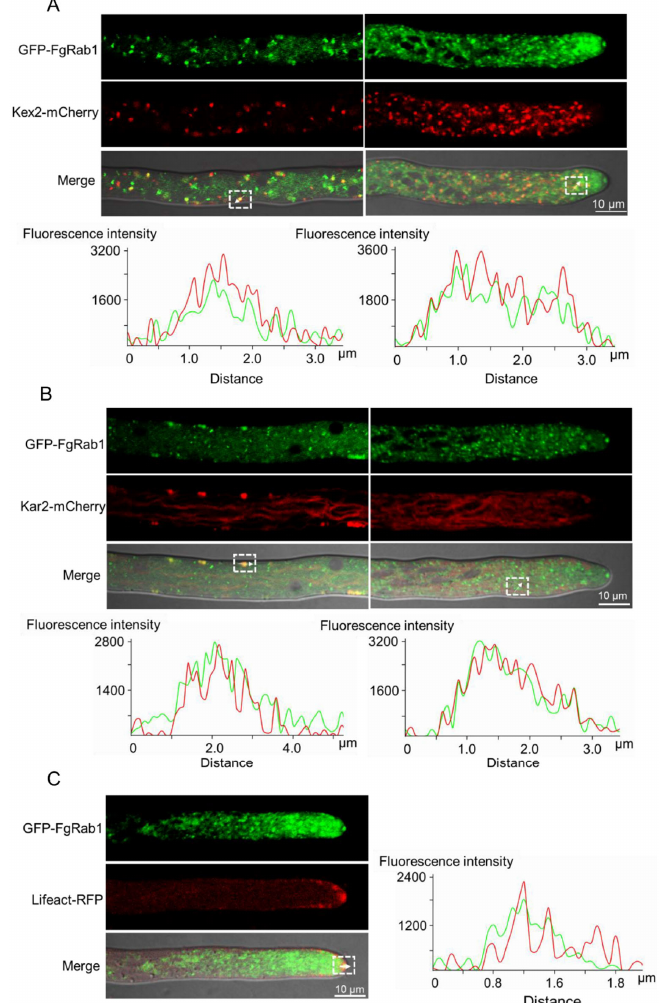
Figure 4. Subcellular localization of FgRab1. ( A ) GFP ‐ FgRab1 co ‐ localizes with the trans ‐ Golgi marker Kex2 ‐ mCherry (marked by white arrows). A line scan graph was generated at the indicated position (arrow) to show the relative localization of GFP ‐ FgRab1 (green) and Kex2 ‐ mCherry (red). ( B ) GFP ‐ FgRab1 and Kar2 ‐ mCherry co ‐ localize to the endoplasmic reticulum (ER) (marked by white arrows). A line scan graph was generated at the indicated position (arrow) to show the relative localization of GFP ‐ FgRab1 (green) and Kar2 ‐ mCherry (red). ( C ) GFP ‐ FgRab1 localizes to the Spitzenkörper (Spk) (marked by white arrows). A line scan graph was generated at the indicated position (arrow) to show the relative localization of GFP ‐ FgRab1 (green) and Lifeact ‐ RFP (red).